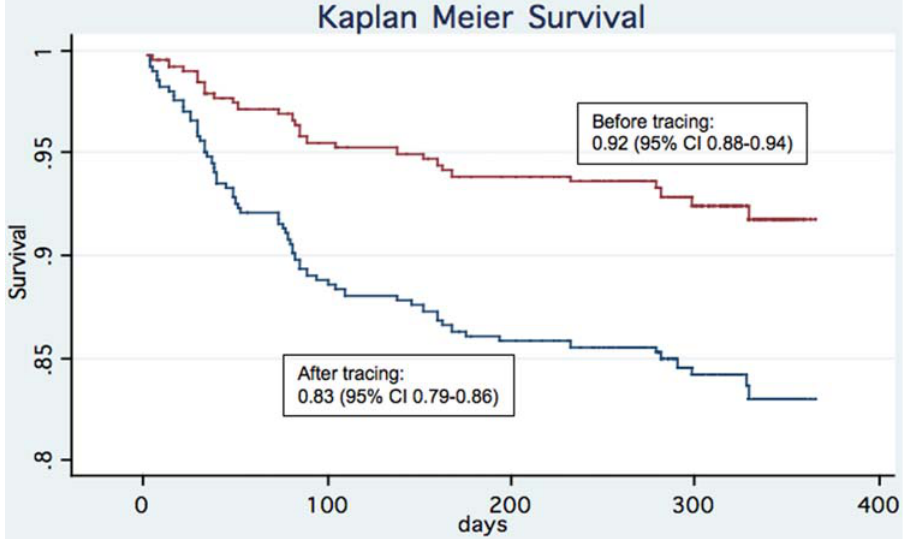
Figure 1. Kaplan-Meier curve 52-week survival estimates before and after patient tracing, IDCC, Gaborone, Botswana. Losses to follow-up are censored. Log rank P , 0.001.